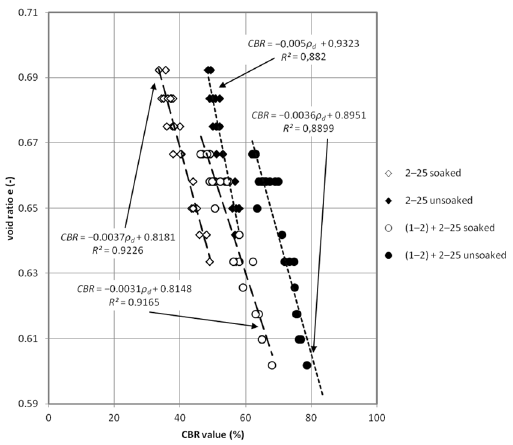
Figure 3. Plot of California bearing ratio (CBR) test results against density of tested samples.